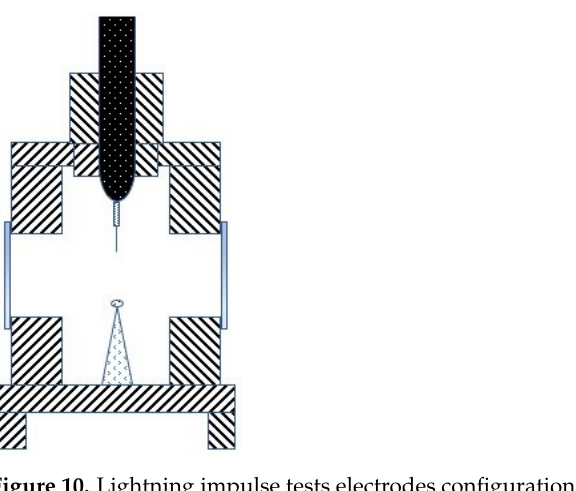
Table 17. Maximal variations of the partial discharge inception voltage and magnitude of the discharges in nanofluids.